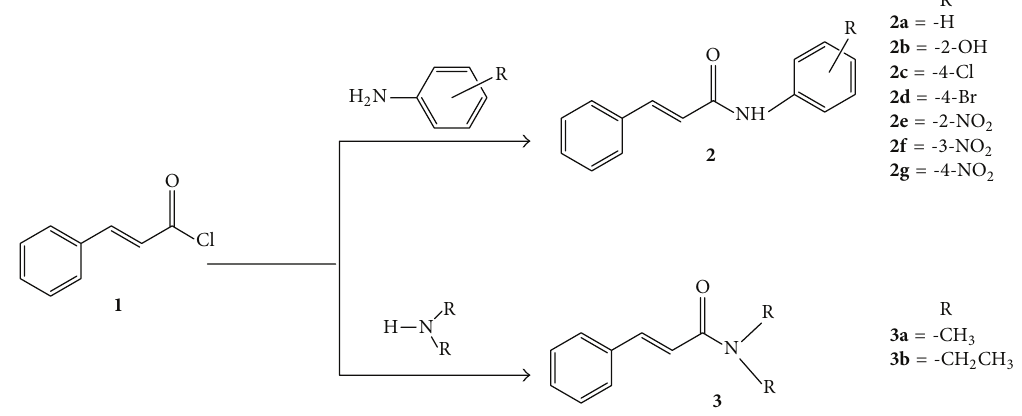
Scheme 1: Synthesis of compounds 2a – 2g and 3a - 3b